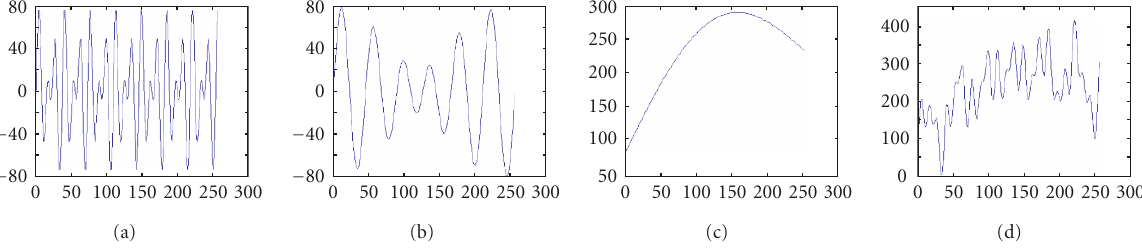
Figure 10: 1D diagonal intensity profiles of (a) STC-1, (b) STC-2, (c) STC-3, (d) STI.